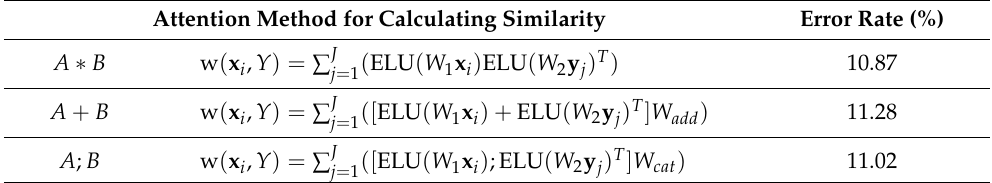
Table 6. Comparison of attention methods in WA on the validation split of IDRad.